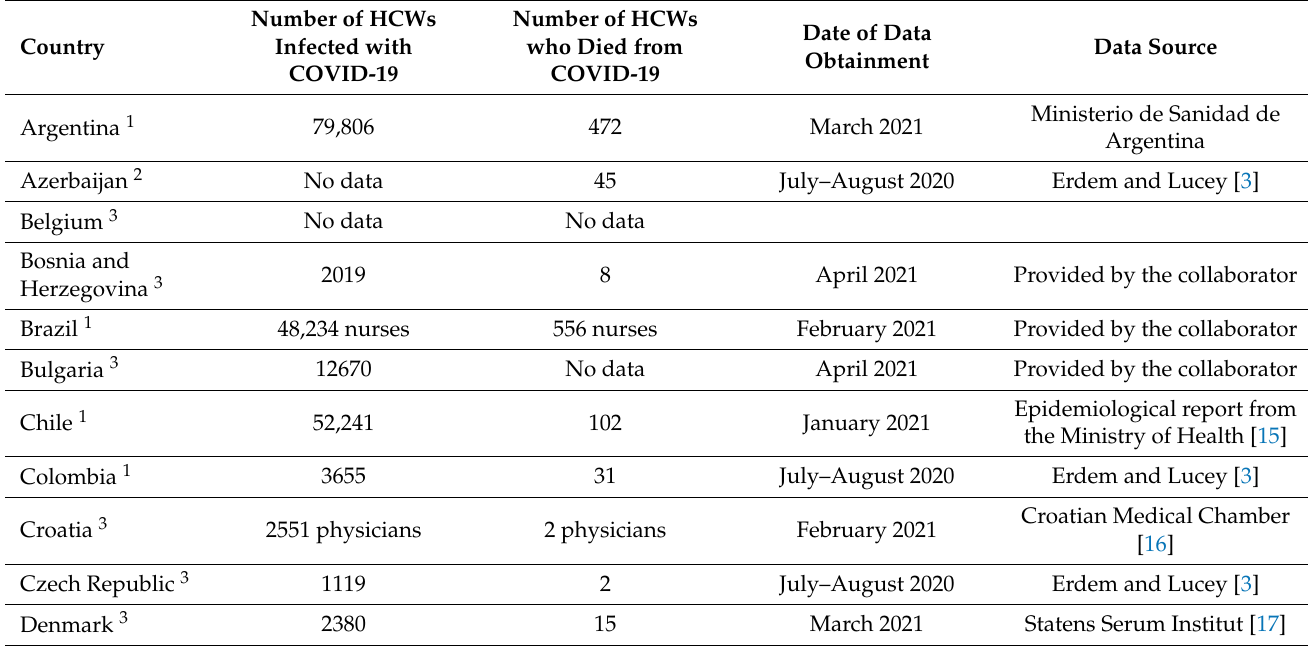
Table 2. The number of healthcare workers (HCWs) who were infected with COVID-19 and the number of HCWs who died from